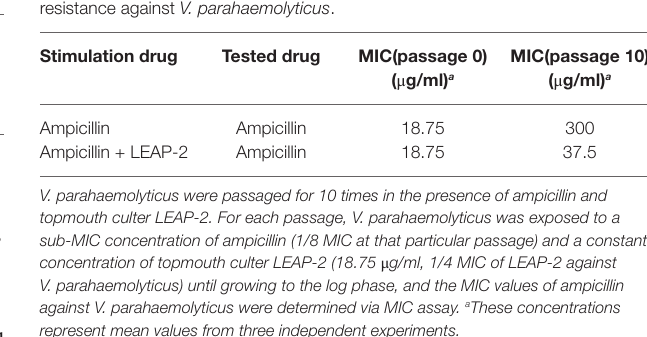
TABLE 6 | MIC assay of ampicillin against fish pathogenic bacteria in the presence of topmouth culter LEAP-2.